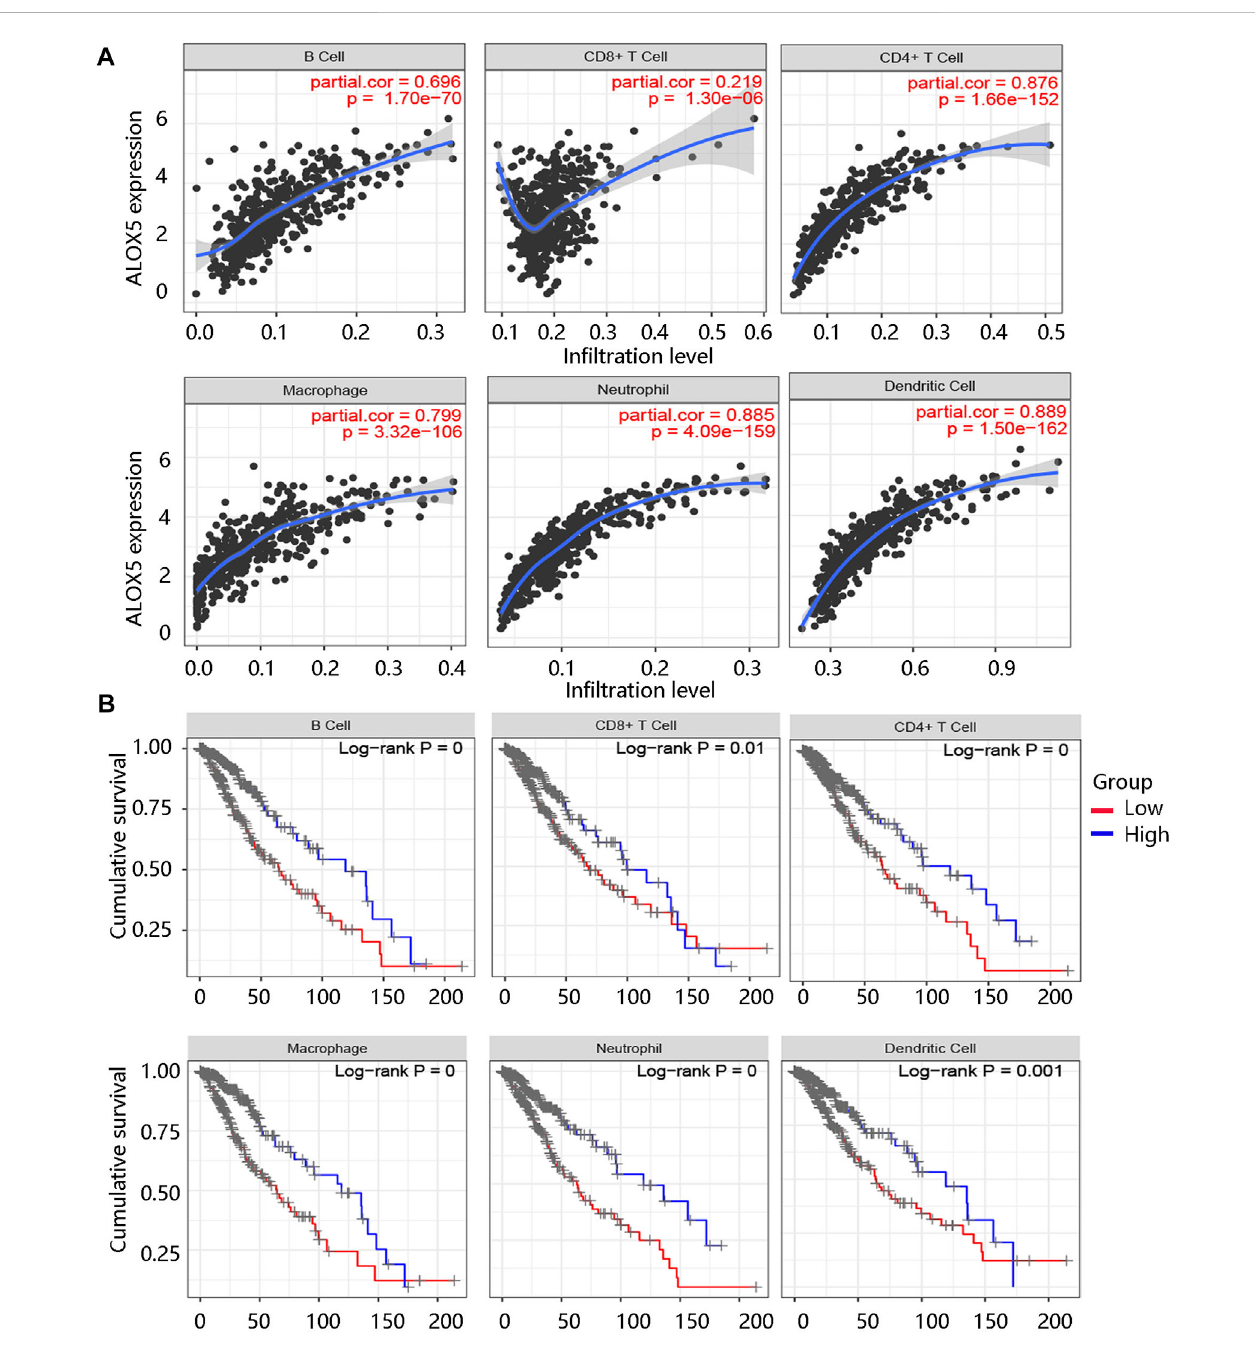
FIGURE 9 Immune cellin fi ltrationanalysisusingTIMERalgorithm. (A) TheassociationofALOX5 expressionwithseveralimmunecellsincludingBcell,CD8+Tcell, CD4 + T cell, macrophages, neutrophil, and dendritic cells. (B) The survival curves of the different immune cell